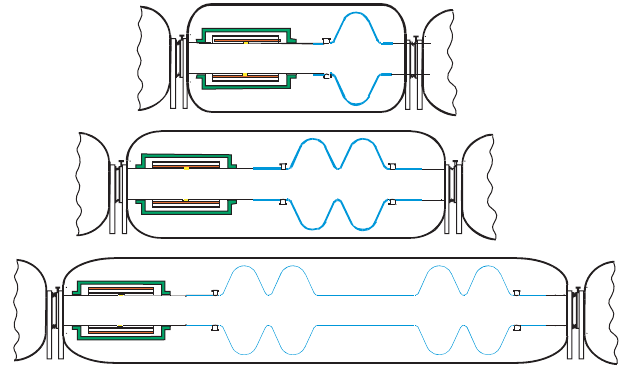
FIG. 21. (Color) Layouts of superconducting linac preacceler- ator cryomodules. Blue lines are the SC walls of the cavities, solenoid coils are indicated in red, and the iron shielding is in green. The dimensions of the cryomodules are shown in Table IV, and Table V summarizes parameters for the